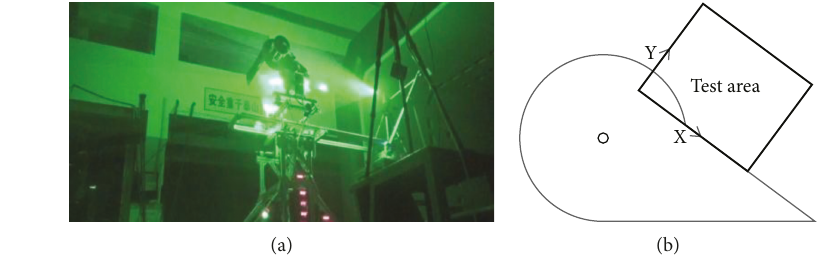
Figure 10: PIV velocity measurement experiment.